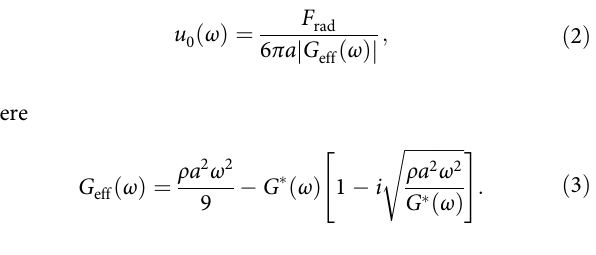
(for example, wavelength and beam waist radius or NA), the refractive indices of the bead and medium, and the position of the bead in 3D space relative to the forcing beam.